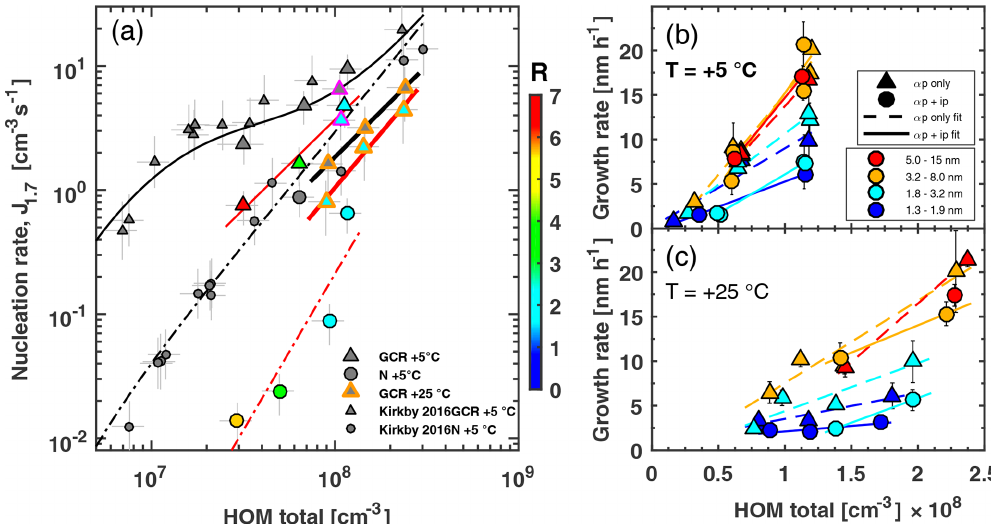
Figure 3. Pure biogenic nucleation rates at 1.7nm diameter (a) and growth rates (b, c) against total HOM concentration with and without isoprene added at + 5 and + 25 ◦ C. HOM total is defined as the sum of C 5 , C 10 , C 15 and C 20 carbon classes. Relative humidity is 38% for all data points. (a) Triangles represent J gcr and circles J n . Small grey points were taken from Kirkby et al. (2016). Magenta edges indicate UV-illuminated conditions at + 5 ◦ C; at + 25 ◦ C all data points are with UV light on. Colour shows isoprene-to-monoterpene carbon ratio ( R ). Black solid and dashed–dotted lines are parameterisations of J gcr and J n from Kirkby et al. (2016). Red solid and dashed–dotted lines are power-law fits to J gcr and J n in the presence of isoprene at + 5 ◦ C. Thick solid black and red lines represent power-law fits to + 25 ◦ C data for α -pinene only and α -pinene + isoprene systems. Bars indicate 1 σ run-to-run uncertainty. The overall systematic scale uncertainty of HOMs of + 78% and − 68% and of J for ± 47% is not shown. In (b) and (c) , triangles represent α -pinene only and circles represent α -pinene + isoprene conditions. Marker colour indicates the size range in which growth rate was measured: dark blue 1.3–1.9nm (measured by scanning PSM), light blue 1.8–3.2nm, orange 3.2–8.0nm (both measured by DMA train) and red 5.0–15nm (measured by nano-SMPS). Bars indicate 1 σ uncertainties in growth rate estimation. Dashed lines are linear fits to α -pinene-only data points; solid lines are linear fits to α -pinene + isoprene